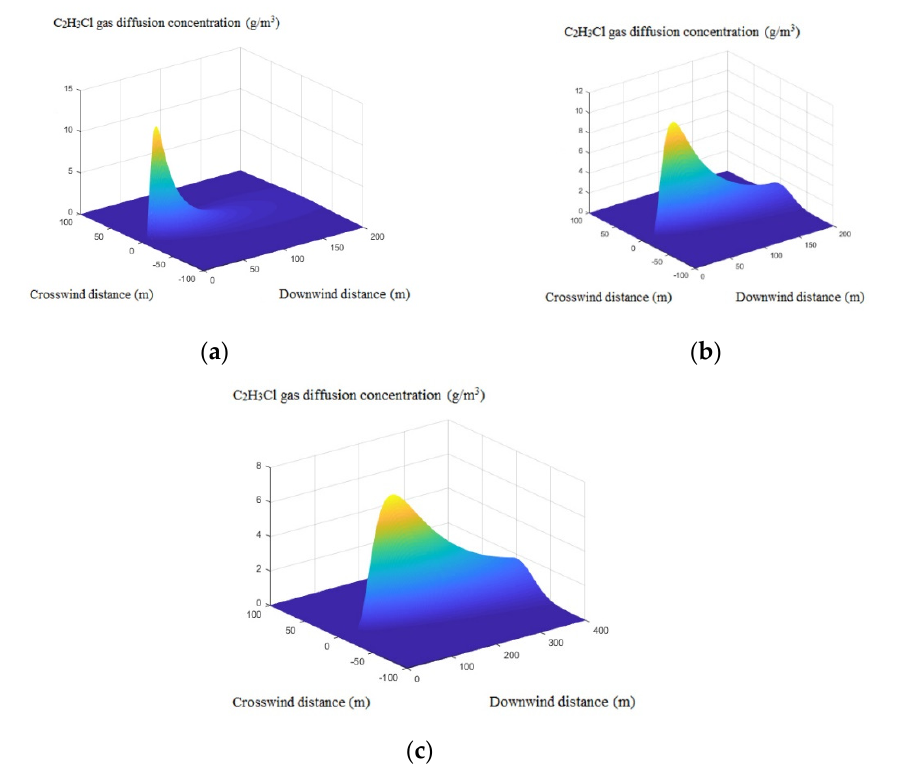
Figure 1. Graph of the concentration changes of vinyl chloride at a height of 2 m from the leak source under different atmospheric stabilities. ( a ) Concentration when atmospheric stability is class A. ( b ) Concentration when atmospheric stability is class C. ( c ) Concentration when atmospheric stability is class E.